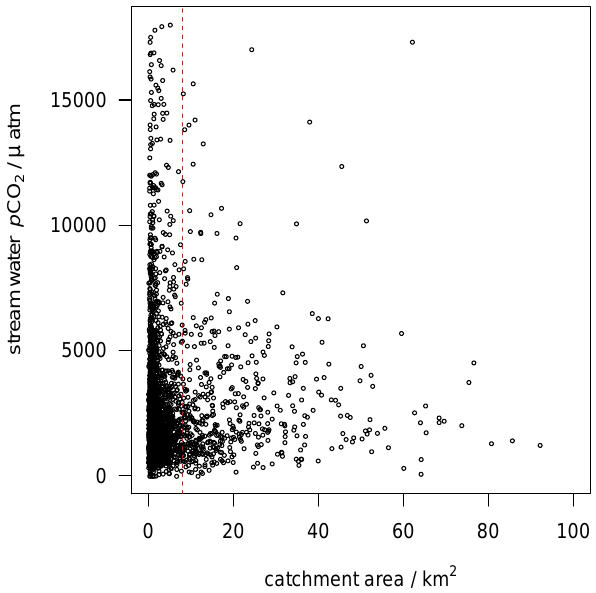
Fig. 3. Scatterplot of headwater catchment area (CA) versus stream water p CO 2 (µatm). The threshold chosen to select a subset of the data corresponding to the smallest headwater catchments ( < 8km 2 ) is shown by the red dashed